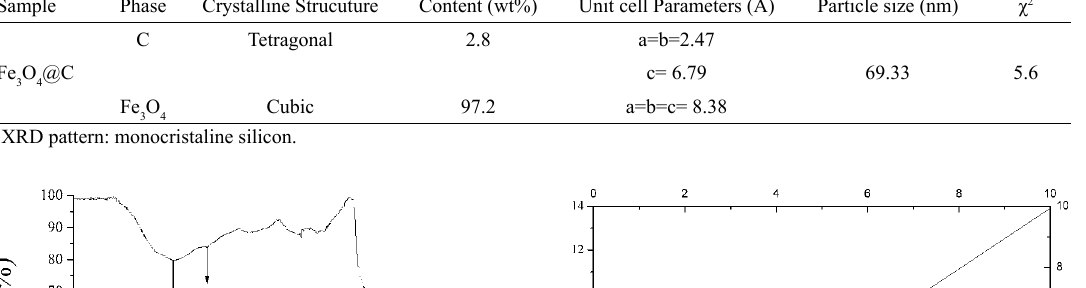
Table 1. Results of Rietveld analysis of Fe Sample